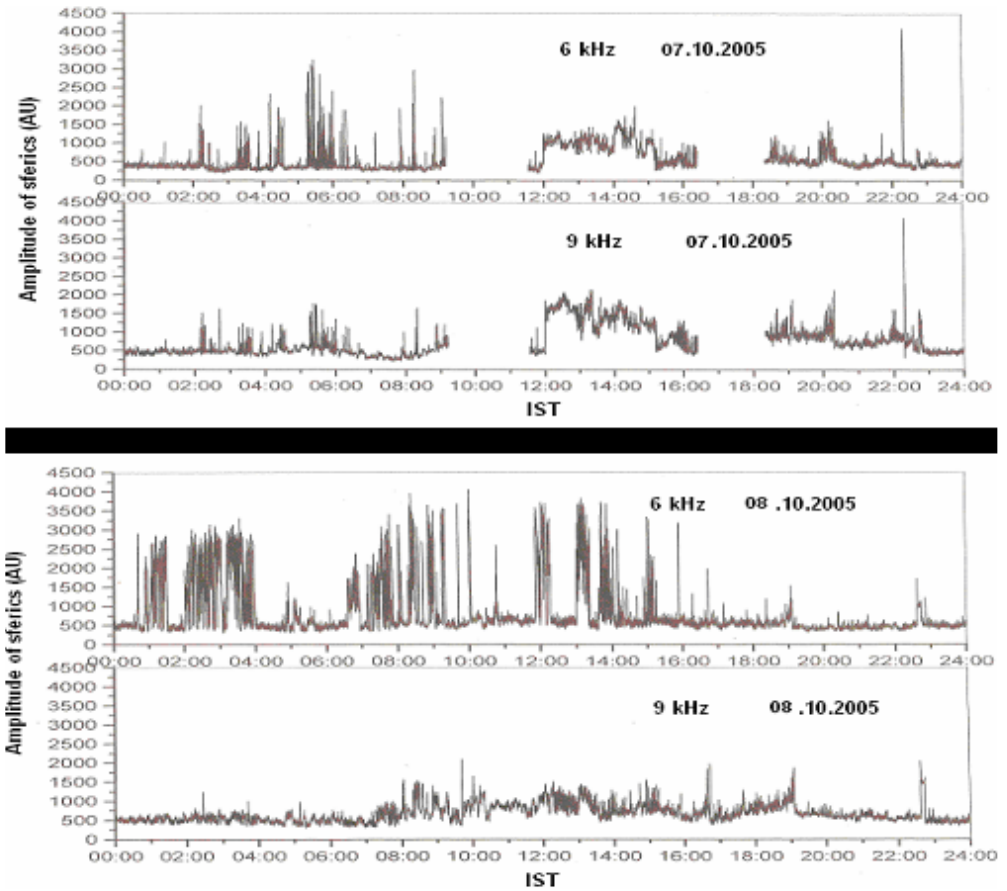
Fig. 10. Diurnal variation of sferics with spikes observed over Agartala on 7 October (upper two records) and 8 October 2005 (lower two